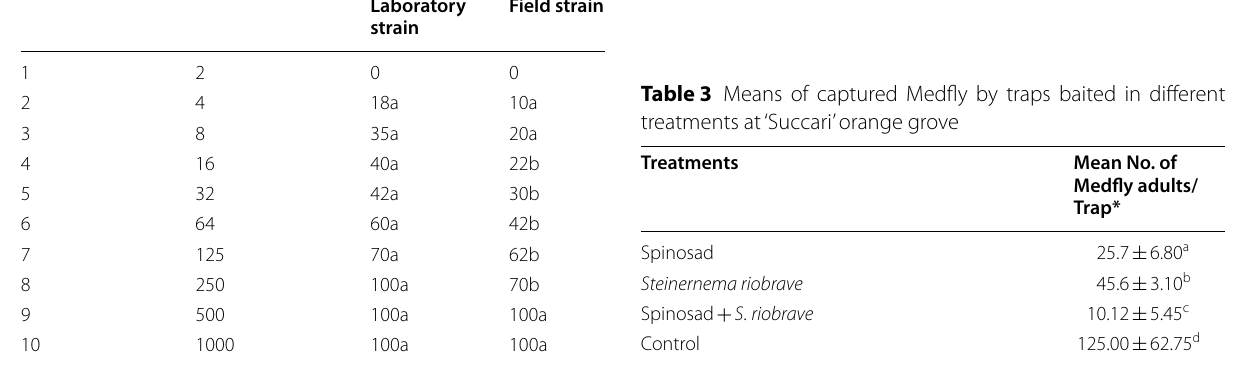
Table 1 Percent mortality of two Ceratitis capitata strains by spinosad doses Concentrations No